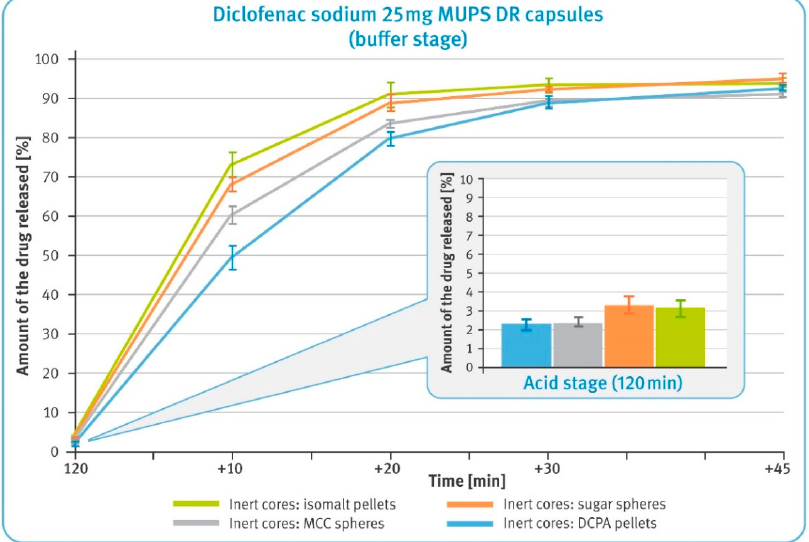
Figure 4. The release of the drug substance from diclofenac sodium 25 mg DR hard gelatin capsules: 2 h incubation in 0.1 M HCl (in the smaller box) and in the buffer phase (phosphate buffer solution, pH 6.8) (mean of n = 6, SD is indicated by the error bars).